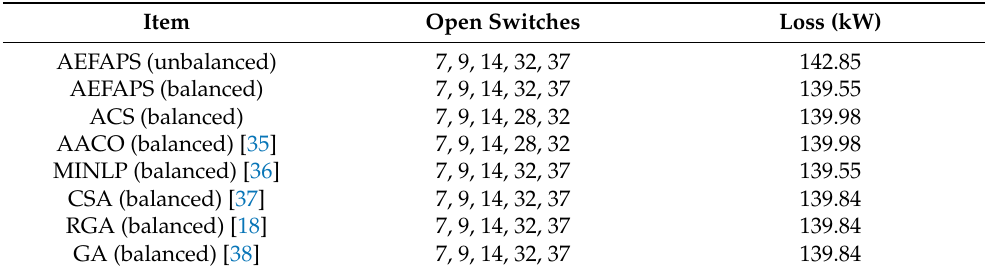
Table 12. Comparative results of the balanced and unbalanced 33-bus network incorporating active